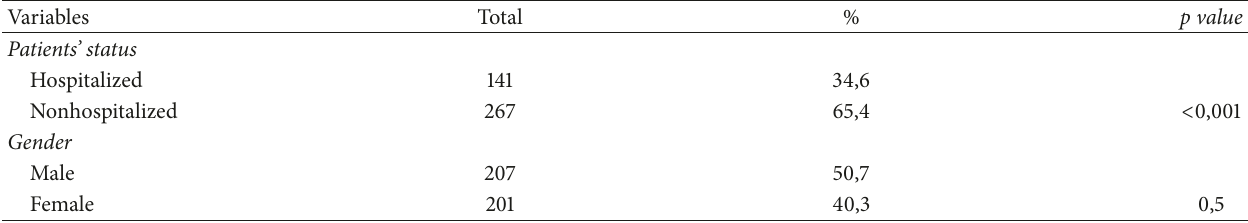
Table 1: Repartition of infestation according to gender and hospitalized or nonhospitalized status of the patients. Variables